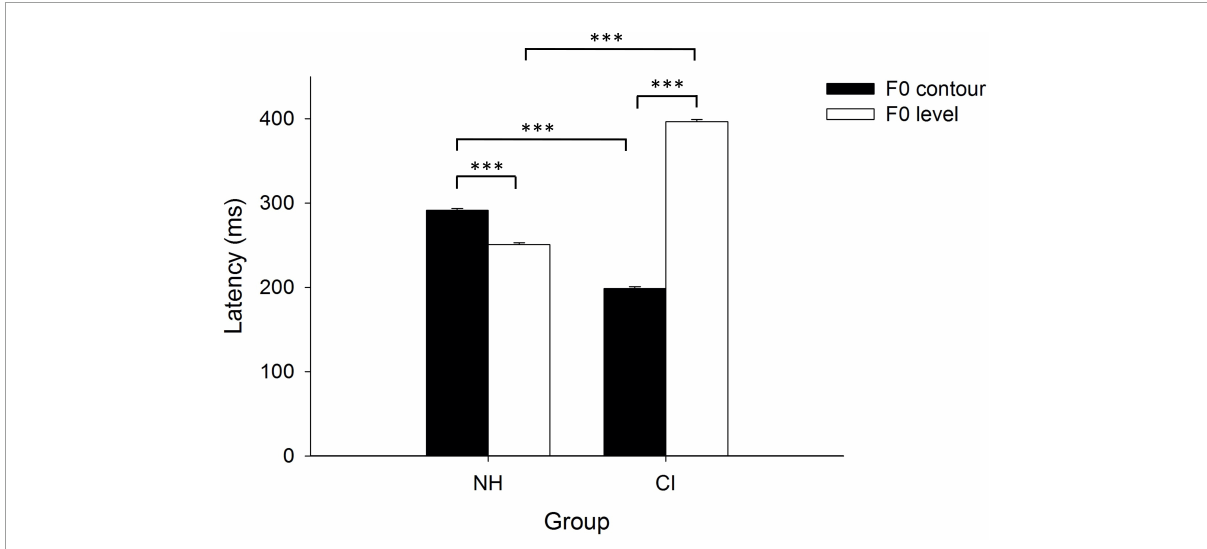
FIGURE5 Peak latencies of positive mismatch responses (p-MMRs) as a function of fundamental frequency (F0) contour and F0 level in both groups. The error bar denotes one standard error of the mean. NH: children with normal hearing; CI: children with CIs. ∗∗∗ p < 0.001.